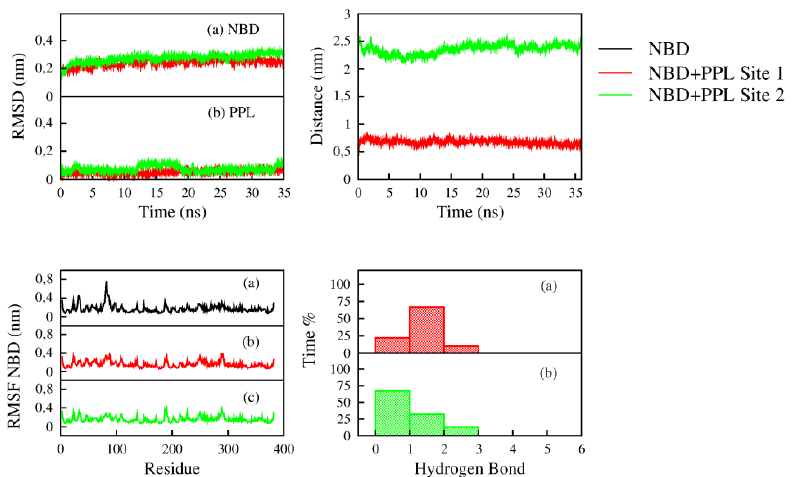
Figure 10. Parameters obtained from the molecular dynamics simulation of the NBD (black), NBD with PPL in Site 1 (red) and Site 2 (green). Top Left : The RMSD of ( a ) protein NBD and ( b ) molecule PPL. Top Right : Distance between COG of NBD and COG of PPL in Sites 1 and 2. Bottom Left : The RMSF of the residues of ( a ) NBD, ( b ) NBD when interacting with PPL in Site 1 and ( c ) NBD when interacting with PPL in Site 2. Bottom Right : The hydrogen bonds performed between NBD and PPL in ( a ) Site 1 and ( b ) Site 2.